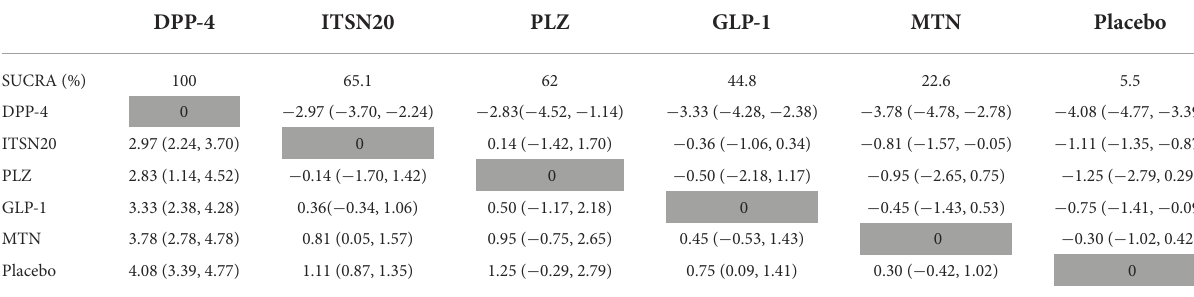
TABLE 2 Matrix of pairwise comparison among hypoglycemic drugs on MMSE score (shown as mean difference and 95% confidence intervals). DPP-4 ITSN20 PLZ GLP-1 MTN